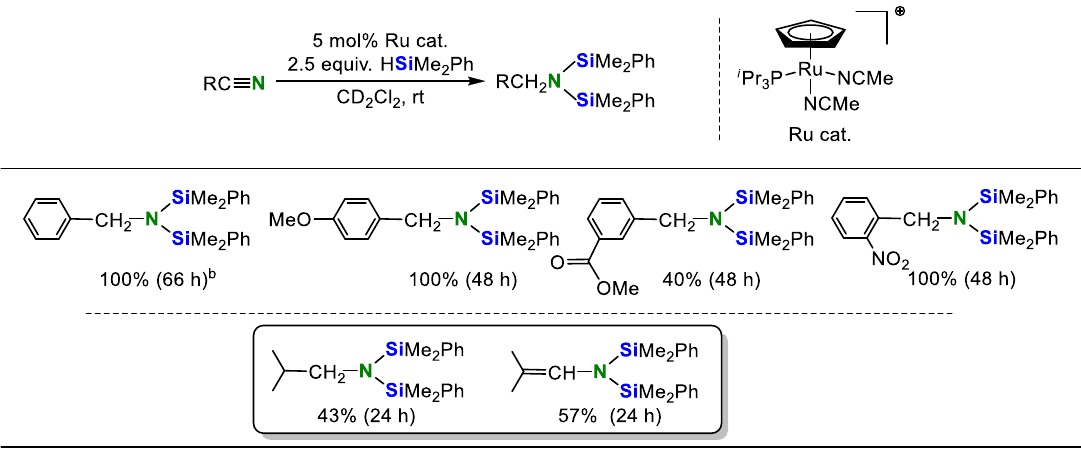
Table 4. Ru-catalyzed double hydrosilylation of nitriles a .